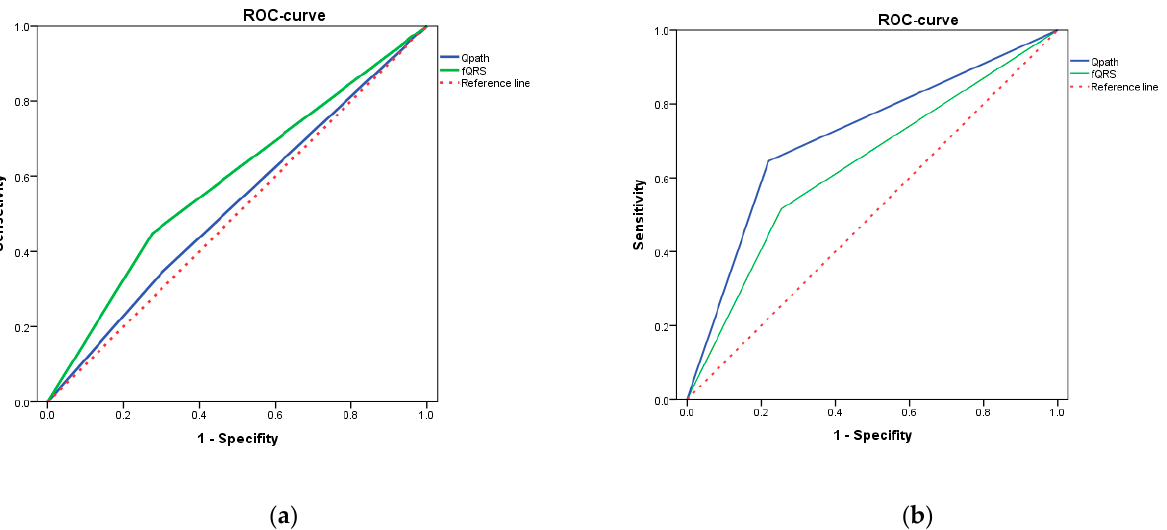
Figure 7. ROC curves for pathological Q wave and fQRS ( a ) in patients with mildly reduced EF; ( b ) in patients with lEF. Qpath—pathological Q wave, FQRS—fragmented QRS complex. Table 4. Value of single-marker detection for patients with mEF and lEF. SEN SPE